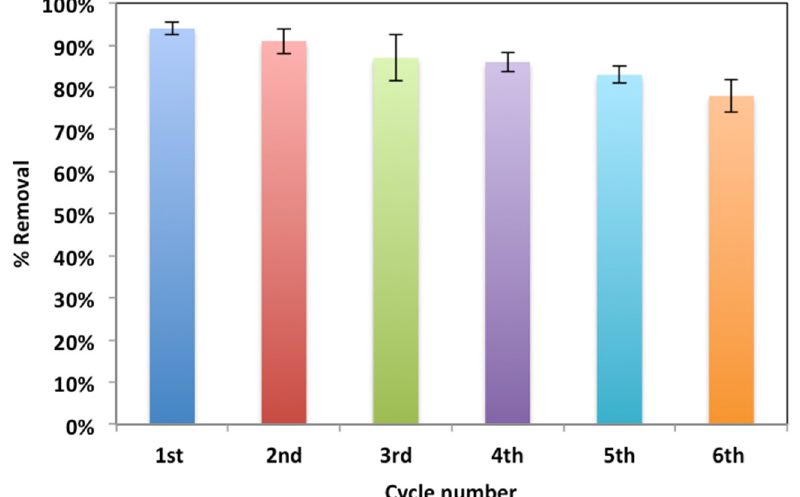
Figure 12. Catalyst recyclability